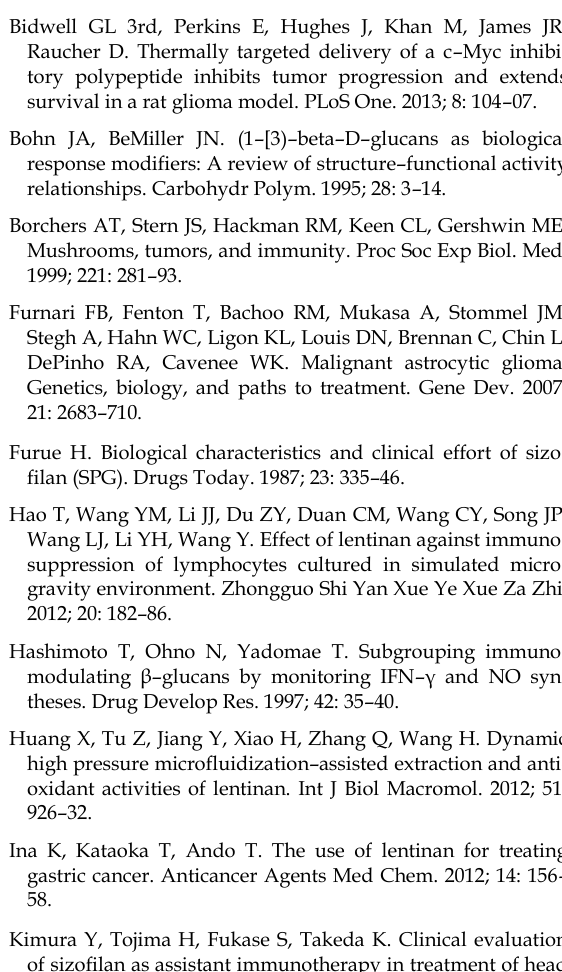
Figure 6: Schizophyllan effects on CNS-1 cell